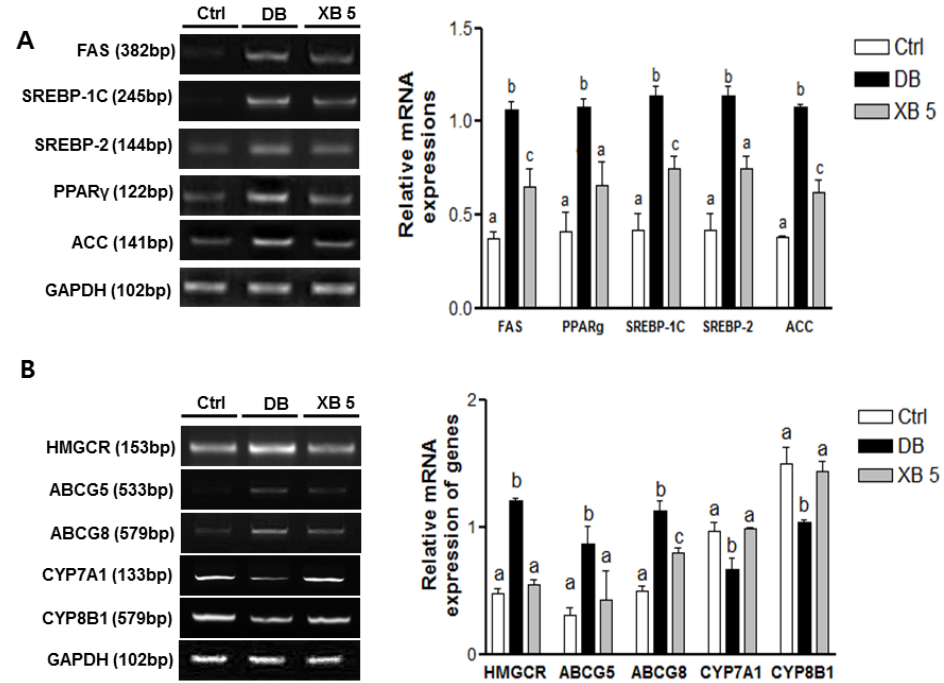
Figure 5. Changes in hepatic lipogenesis and cholesterol homeostasis genes. ( A ) Lipogenesis ‐ related genes, including FAS (Fasn), PPAR γ (Pparg), SREBP ‐ 1C (Srebf1), SREBP ‐ 2 (Srebf2), and ACC (Acaca) mRNA expressions were analyzed in liver tissues; ( B ) cholesterol homeostasis ‐ related genes, including HMGCR (Hmgcr), ABCG5 (Abcg5), ABCG8 (Abcg8), CYP7A1 (Cyp7a1), and CYP8B1 (Cyp8b1) mRNA, were analyzed in liver tissues. Representative blots are shown in the left panel. Band intensities were quantified by densitometry and analyzed with one ‐ way ANOVA with Newman–Keuls post hoc test. GAPDH (Gapdh) was used as the loading control. The values shown are the mean ± SEM. a,b,c For a given column, data not sharing a common superscript letter significantly differ ( p < 0.05; Ctrl, n = 11; DB, n = 10; XB 5, n = 10). Ctrl, non ‐ diabetic mice; DB, diabetic mice; XB 5, diabetic mice that received an AIN ‐ 93G diet with 5% of the total sucrose content replaced